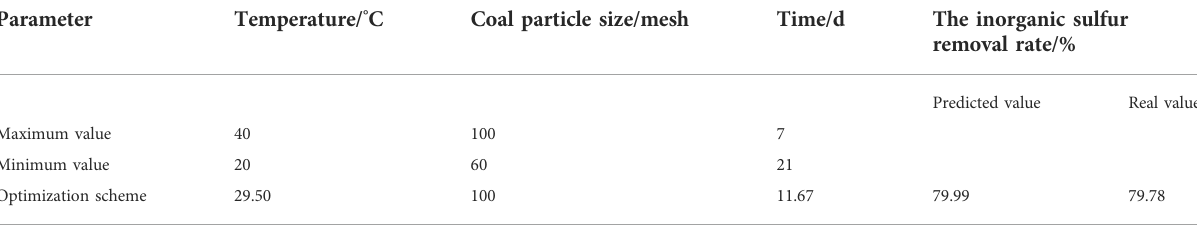
TABLE 10 Optimal parameters design of the inorganic sulfur removal rate. Parameter